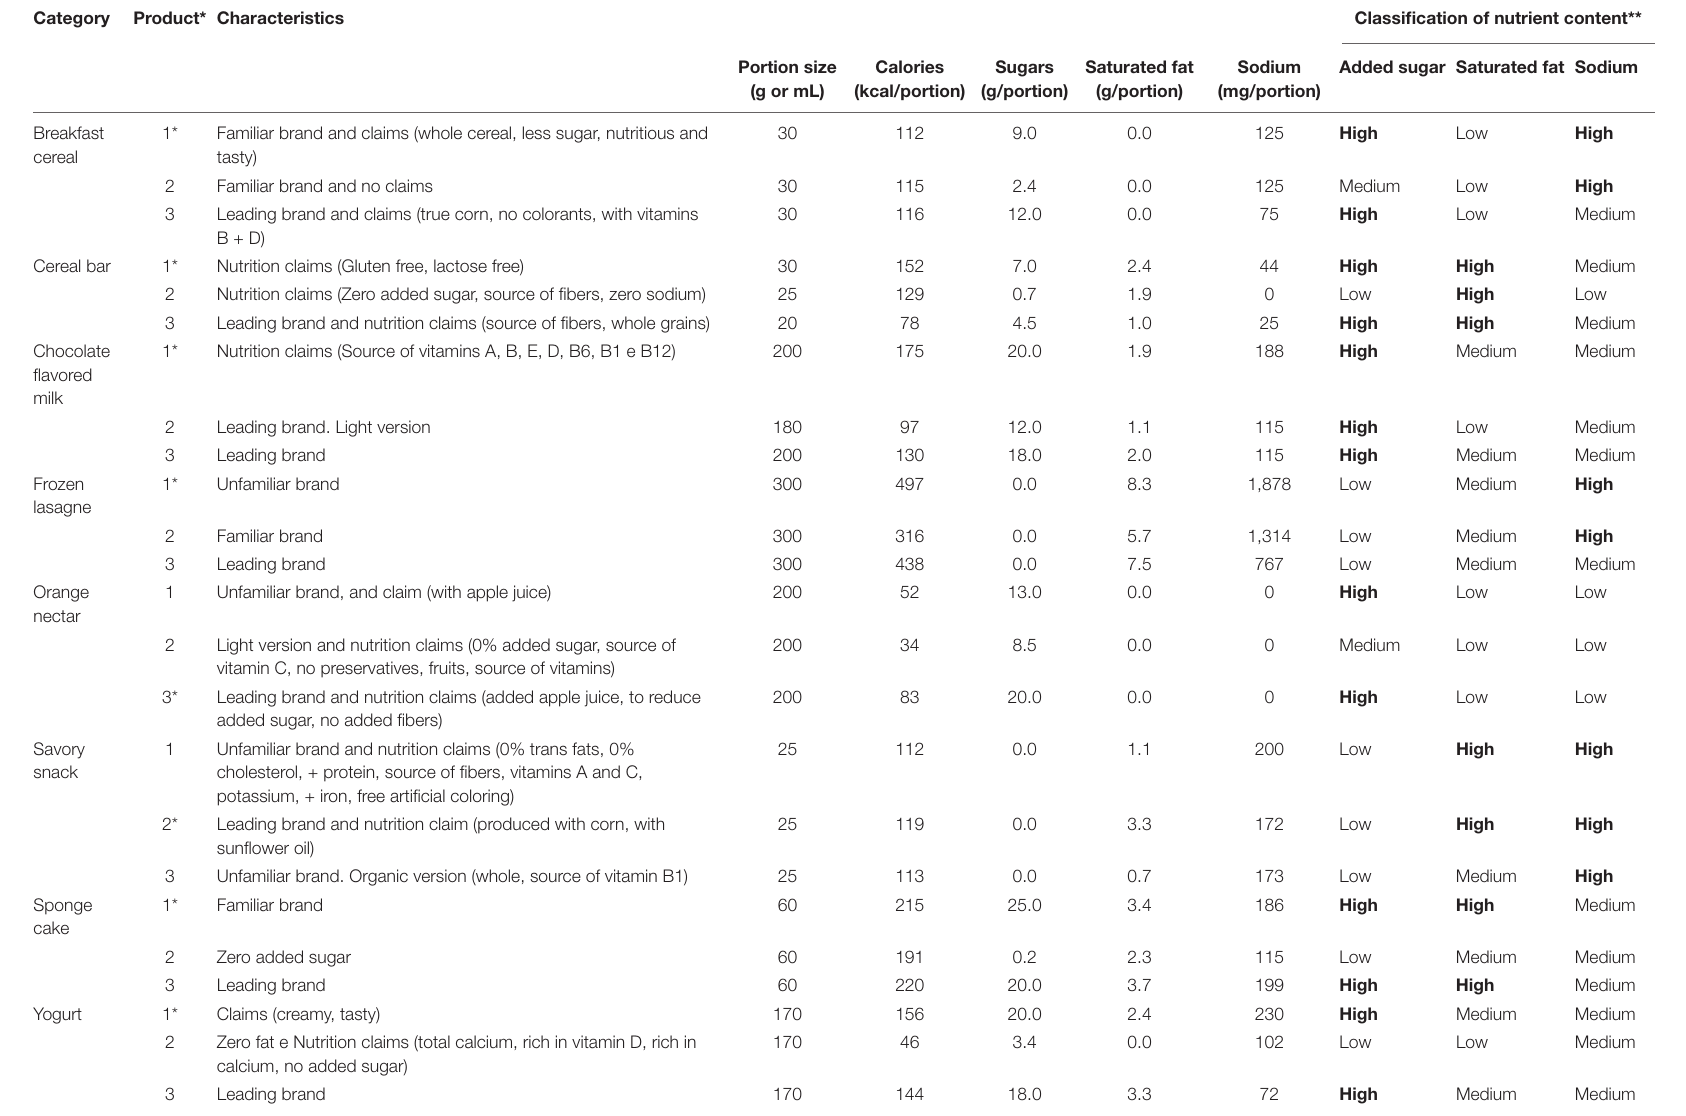
TABLE 2 | Nutritional composition of the products included in the study, and classification of nutrients associated with non-communicable diseases according to the criteria of the Brazilian Health Regulatory Agency (ANVISA) (32). Category Product*